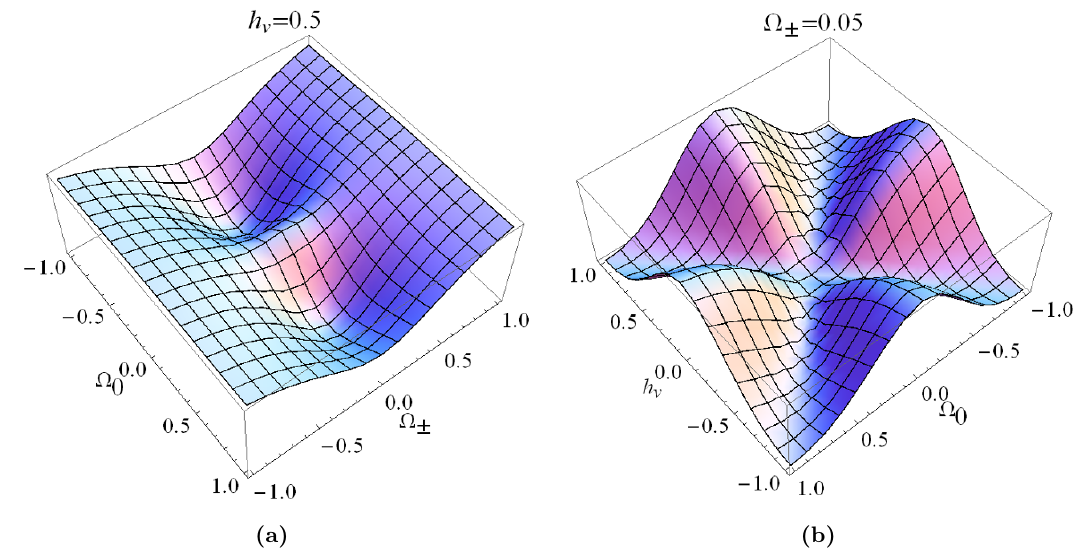
Figure 1. The isosurfaces of the potential W ( h v ; (cid:10) 2 (in units of M Pl ), where m A = 200 GeV, (cid:24) 1 = (cid:24) 2 =